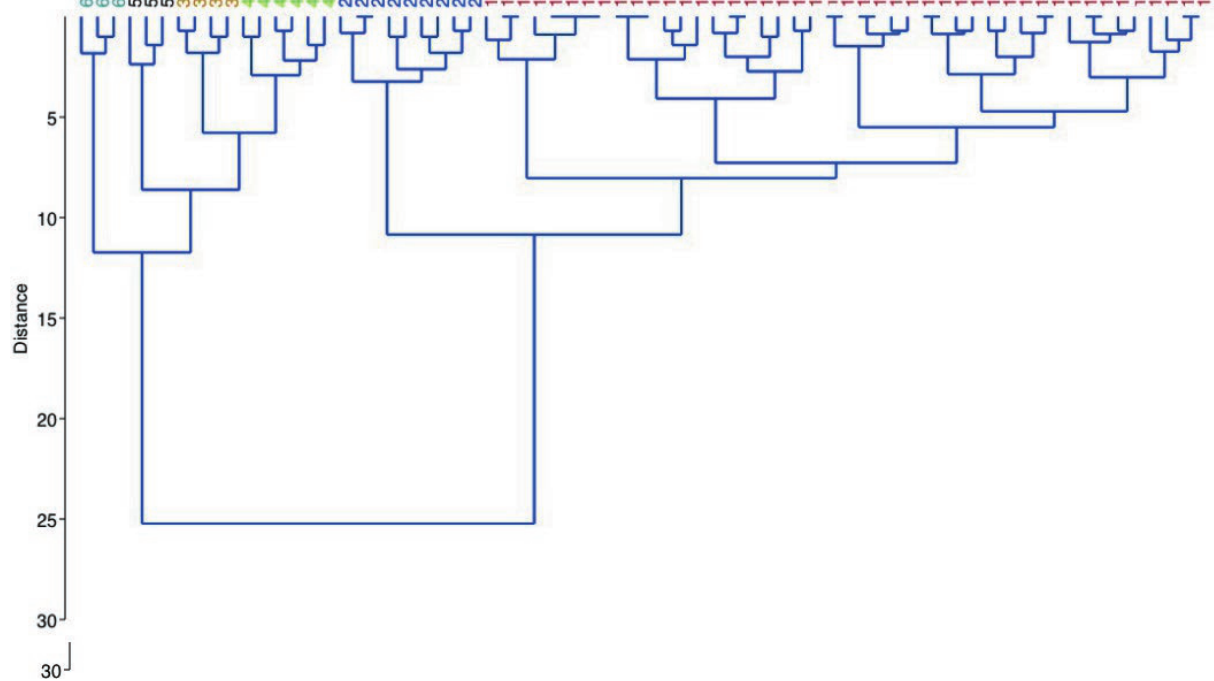
Figure 5. Ward dendrogram of the geographical regions 1-6 are: 1) Combined Mazandaran and Gilan samples, 2) Golestan, 3) Isfahan, 4) Khuzestan, 5) Fars, and 6)